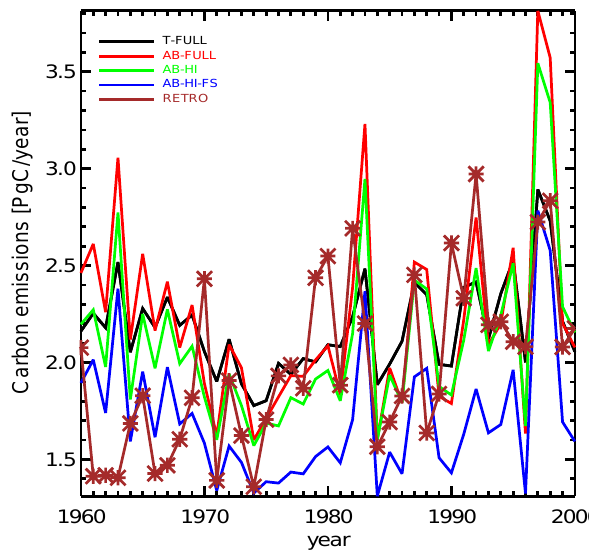
Fig. 11. Annual mean total (wildfire and deforestation) fire carbon emissions in [PgC / year] for the different simulations from 1960–2000 compared to values reported in RETRO (Schultz et al., 2008).